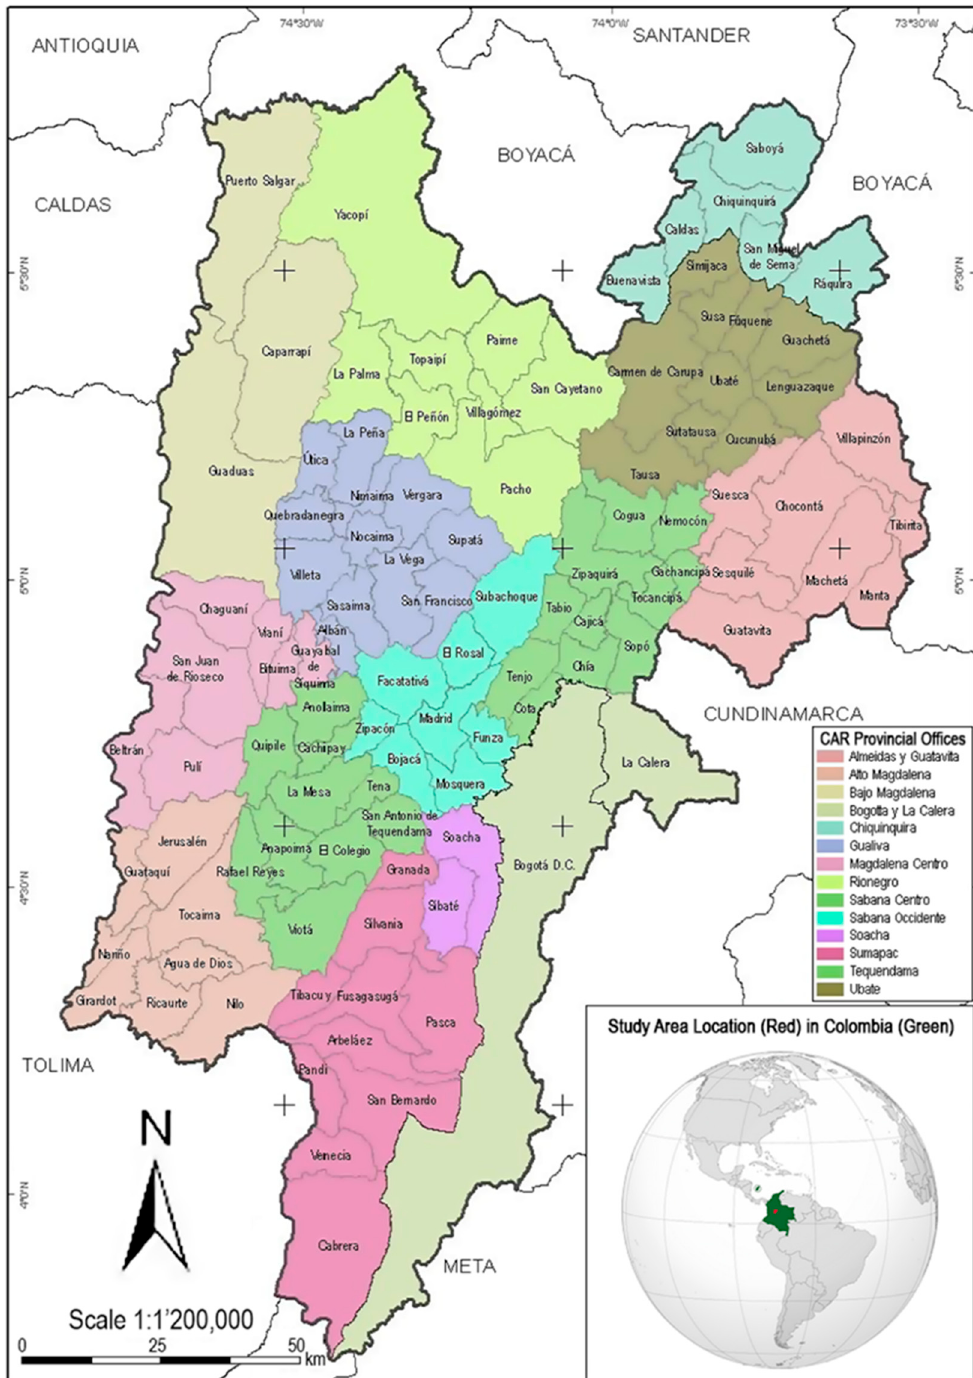
Figure 1. Location of the regional autonomous corporation study area in Cundinamarca, Colombia.